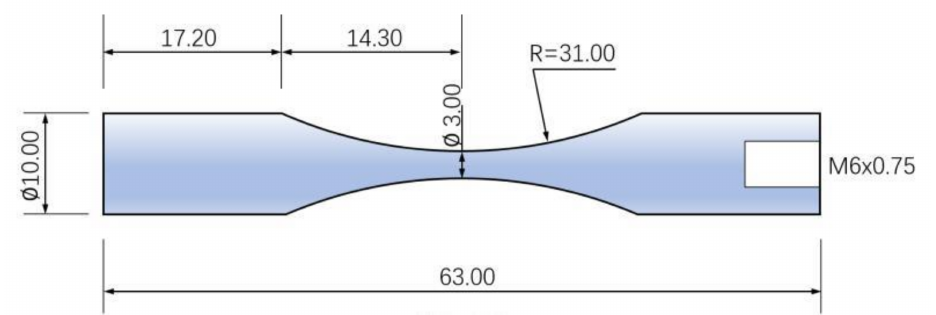
Figure 2. Geometry and dimensions of the test specimen